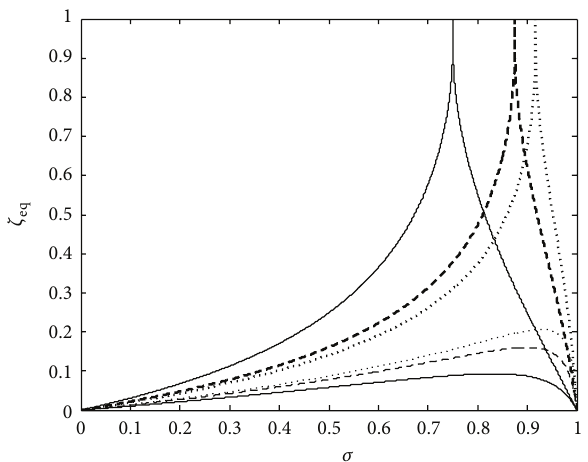
Figure 7: Values of the stiffness reduction ratio 𝜎 and mass ratio Figure 6: Equivalent damping ratio 𝜁 as a function of the stiffness eq 𝜇 corresponding to different values of secondary to primary system reduction ratio 𝜎 for different values of the secondary to primary frequency ratio Ω which give maximum energy dissipation in the system frequency ratio Ω (— Ω = 3 ; - - - Ω = 7 ; ⋅ ⋅ ⋅ Ω = 11 ; — Ω = 5 ; impacting model (— 𝜎 ; - - - 𝜇 − − Ω = 9 ; - - - Ω = 13 ).